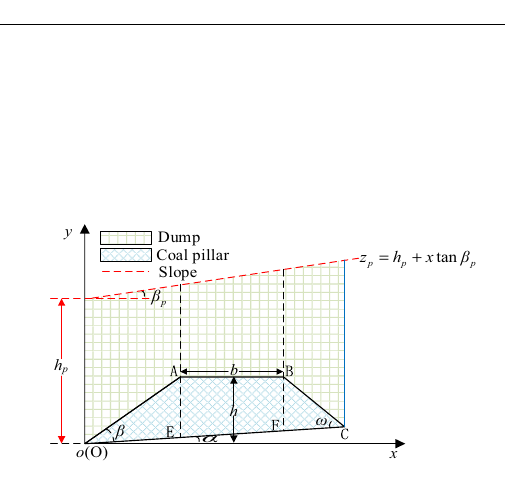
Fig. 7 Development of dumping to coal pillar top Fig. 8 Development of dumping to entire coal